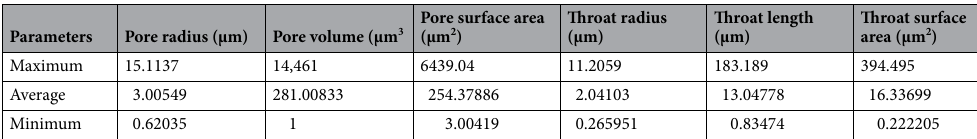
Table 5. Quantitative parameter statistics of pore network model in nylon